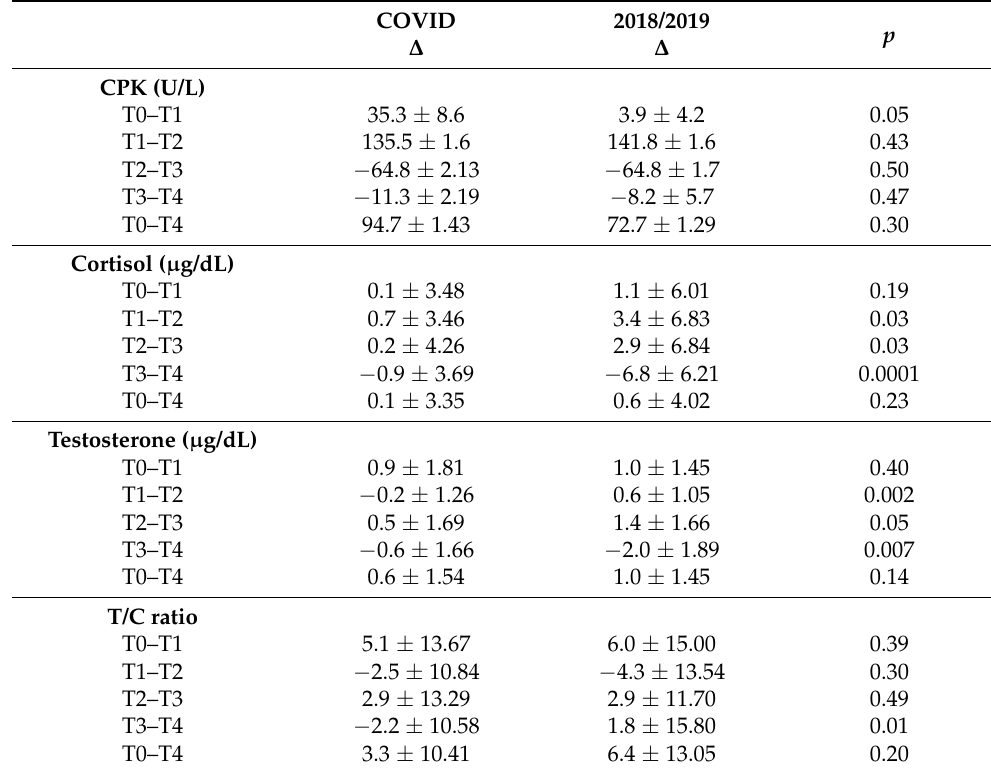
Table 5. Differences ( ∆ ) in CK, cortisol, and testosterone concentration and T/C ratio between each timepoint in football players all for 2018/2019 and 2019/2020. p -values < 0.05 obtained by t -test show statistical differences in ∆ values.